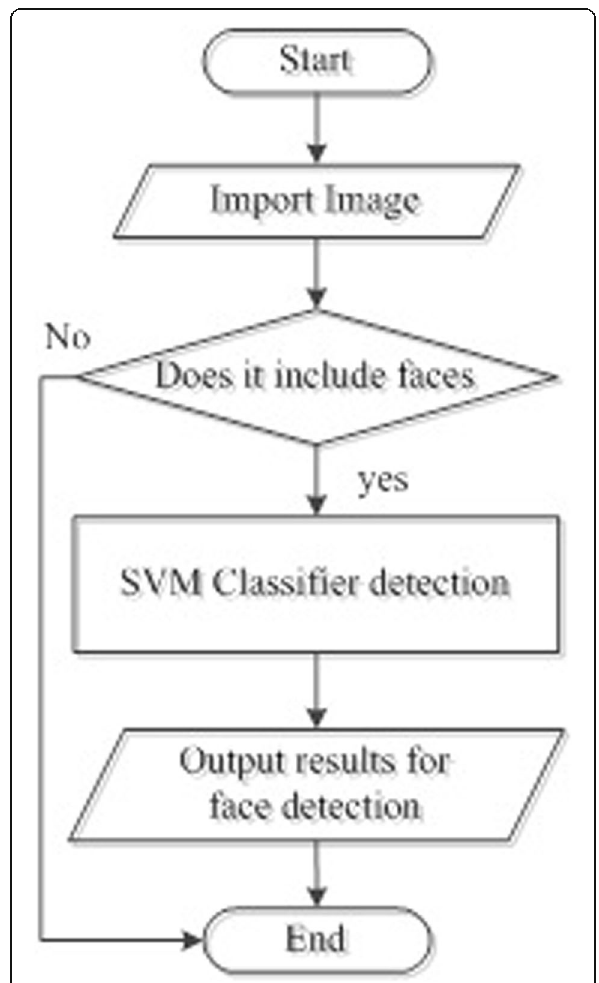
Fig. 3 The detection process of SVM